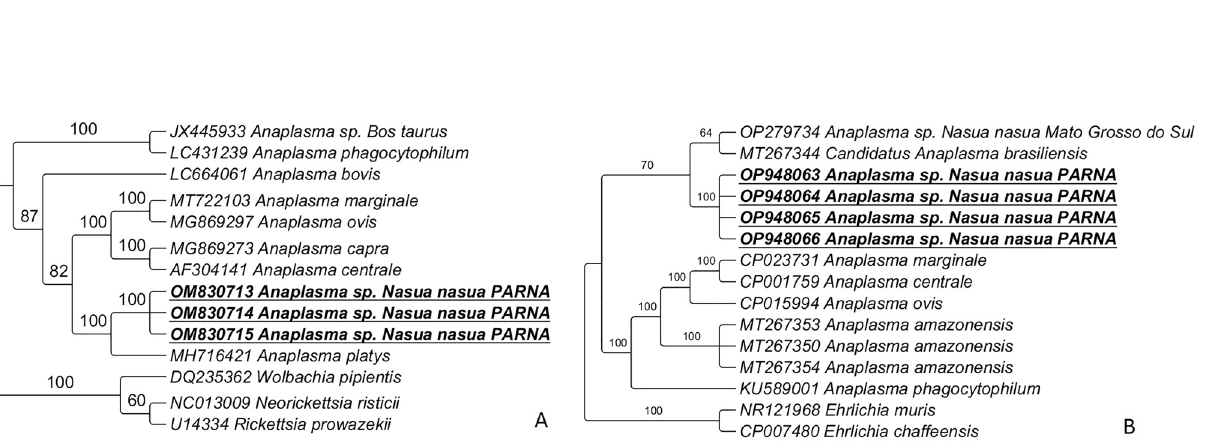
Figure 3. Phylogenetic trees inferred by the Bayesian method and based on Anaplasma spp. sequences obtained from blood from ring-tailed coatis ( Nasua nasua ) from PARNA. Sequences of Anaplasma sp. detected in the present study are highlighted in bold/underlined. ( A ) gltA gene; N. risticii, Wolbachia pipientis and Rickettsia prowazekii were used as outgroup; ( B ) ITS—23S–5S; Ehrlichia muris and Ehrlichia chaffeensis were used as